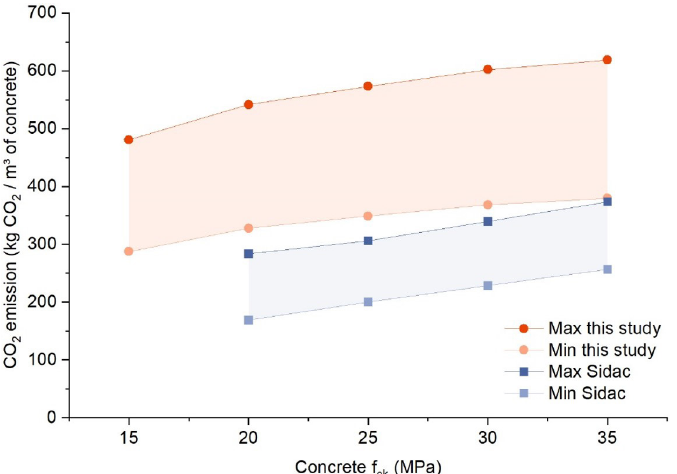
Figure 8. CO 2 emissions for concretes of different grades produced in Acre calculated using the methodology developed in the study in comparison with CO 2 emissions for similar concretes available in the Sidac